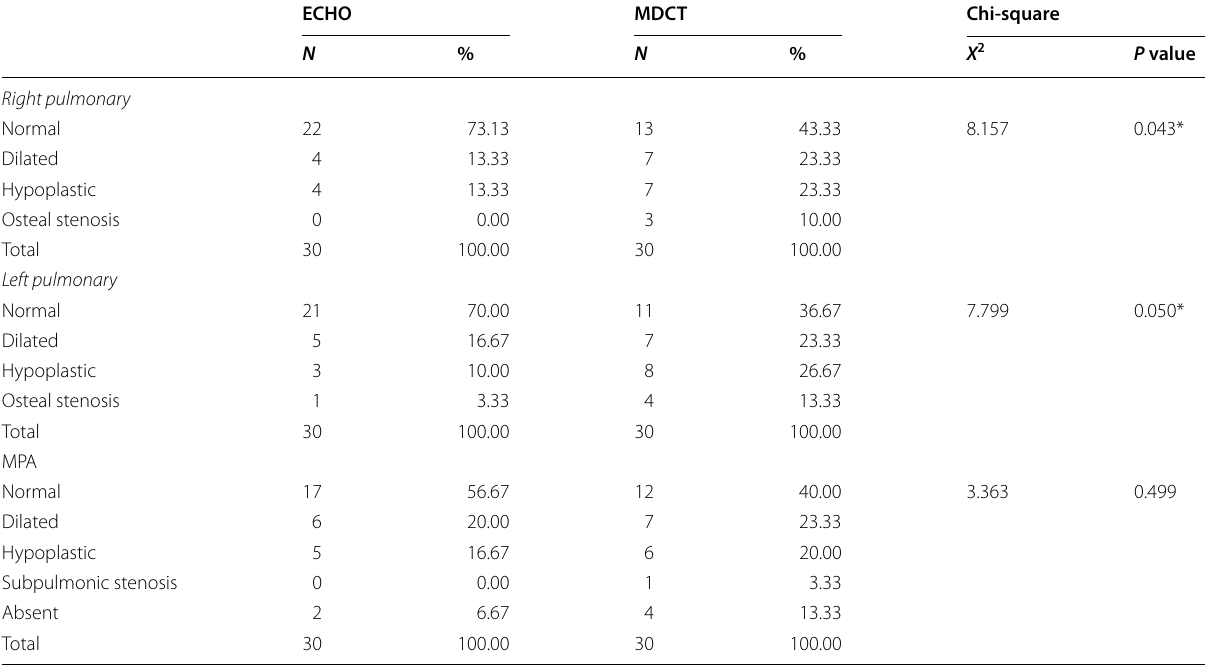
Table 7 Right, left, and main pulmonary arteries abnormalities detected by Echocardiography and MDCT angiography